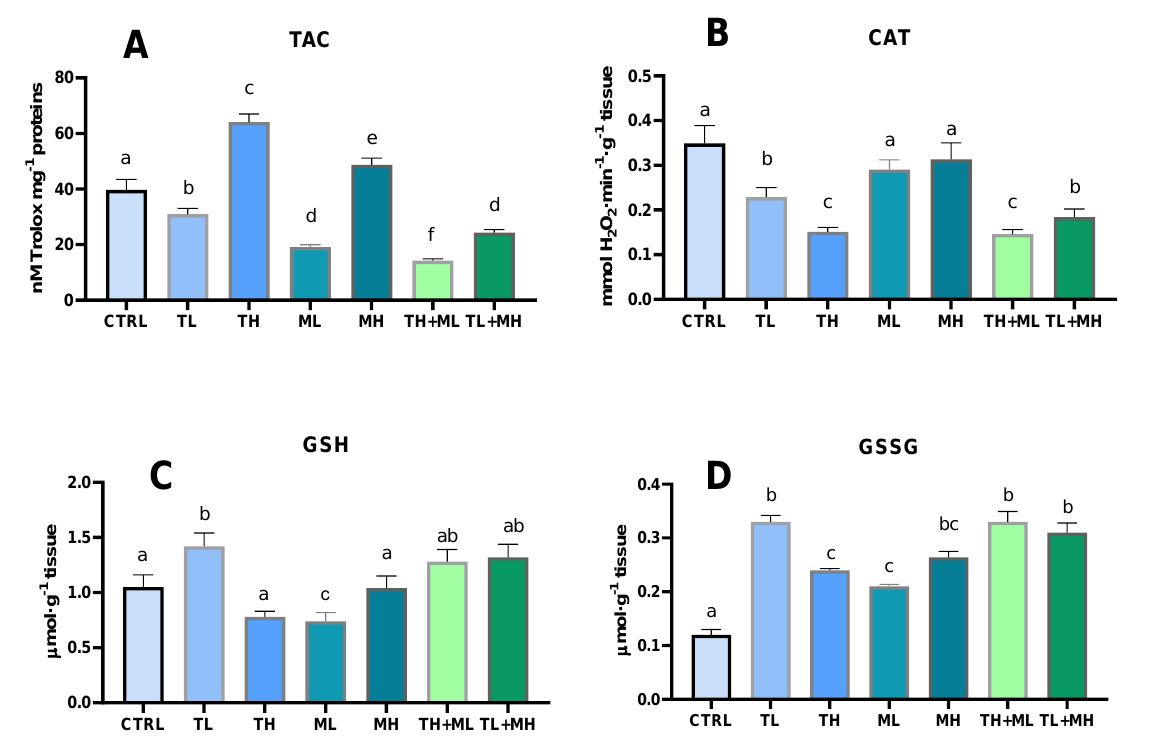
Figure 1. Effects of terbuthylazine (2 µ g L − 1 (TL) and 30 µ g L − 1 (TH)) and malathion (5 µ g L − 1 (ML) and 50 µ g L − 1 (MH)) exposures on antioxidants status in the liver of zebrafish. ( A ) Total antioxidant capacity; ( B ) catalase; ( C ) Glutathione total; ( D ) Glutathione oxidized. When columns share the different letters (a–f), they represent significantly different values ( p < 0.05). The means and the standard errors of the mean are presented. N = 6.